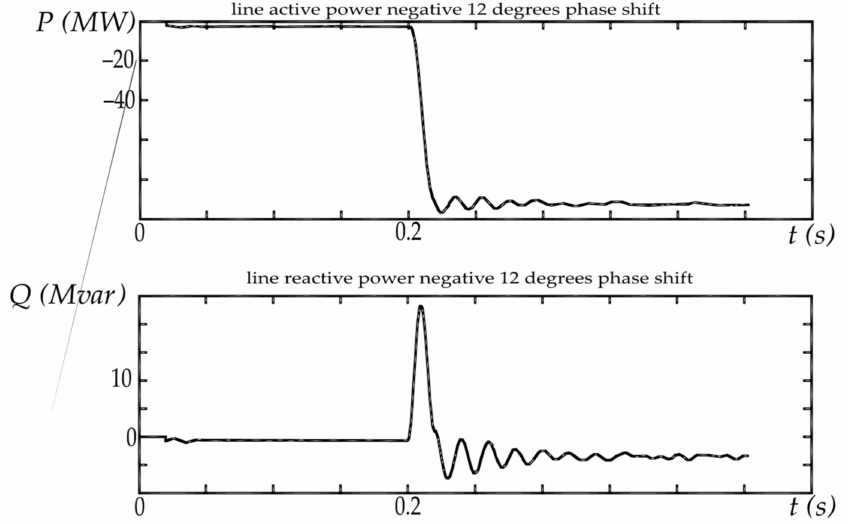
Figure 17. Power-flow interruption after a − 12 ◦ phase shift in the MC output voltage for the “as close as possible” approach and the 12 × 12 MC.